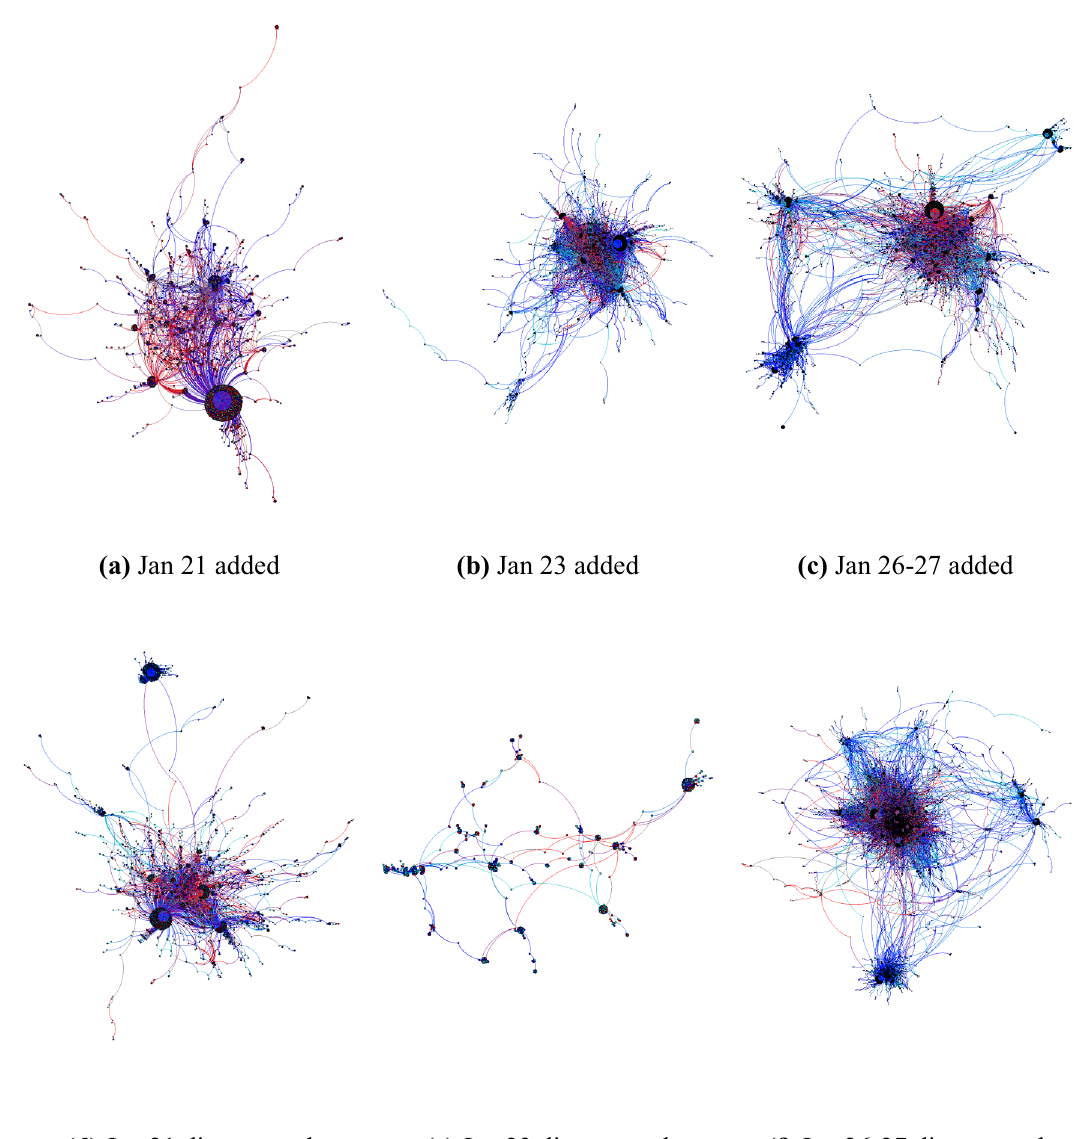
Figure 3. The same networks of added connections (top) and disappeared connections (bottom) as shown in Fig. 2 for each of the three internet outage events in Venezuela now colored by location (Venezuela—red, outside